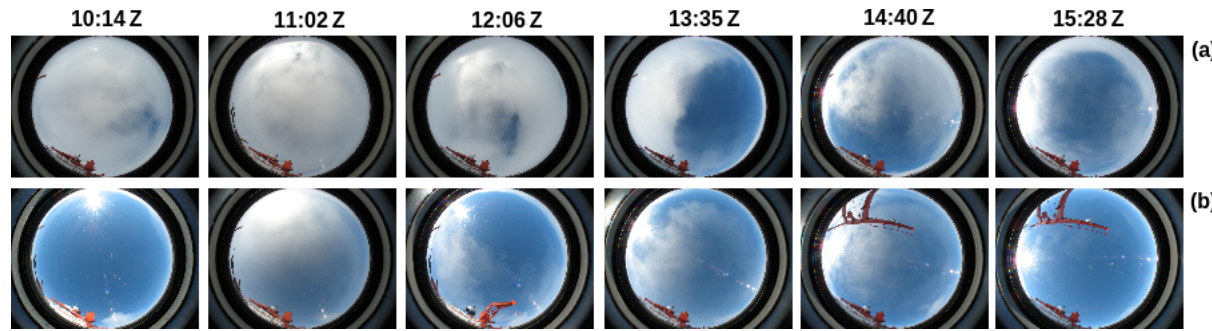
Figure 13. All-sky camera photographs for (a) 7 June and (b) 8 June, taken at different times throughout the